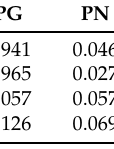
(30 °C, ambient humidity); CC, Climate chamber (40 °C, 75% RH).